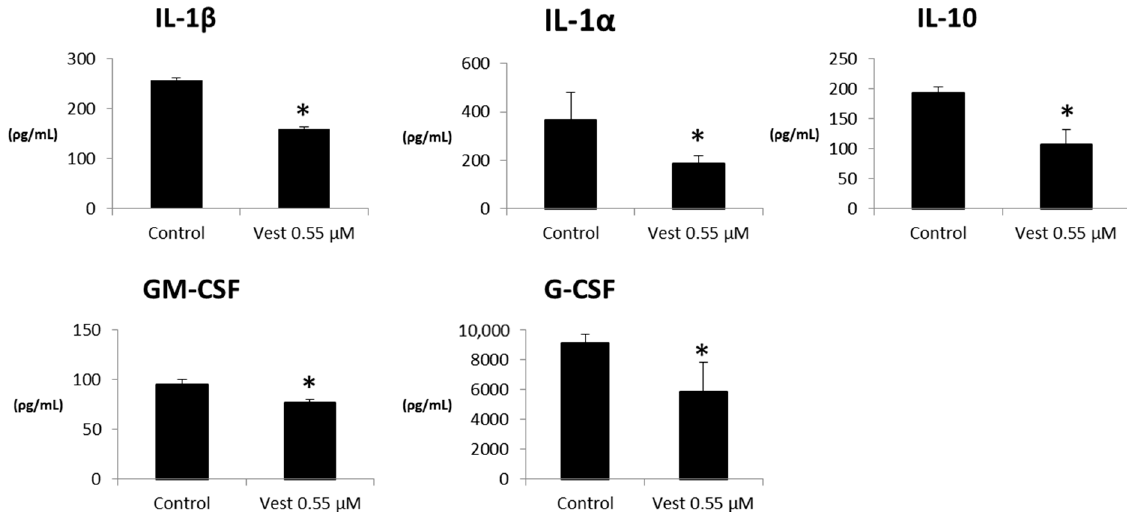
Figure 2. Cytokines profile of LPS-activated peritoneal macrophages treated with (3 S )-Vestitol 0.55 µM (n = 6). * statistical difference compared to vehicle-control group (Mann-Whitney, p < 0.05).